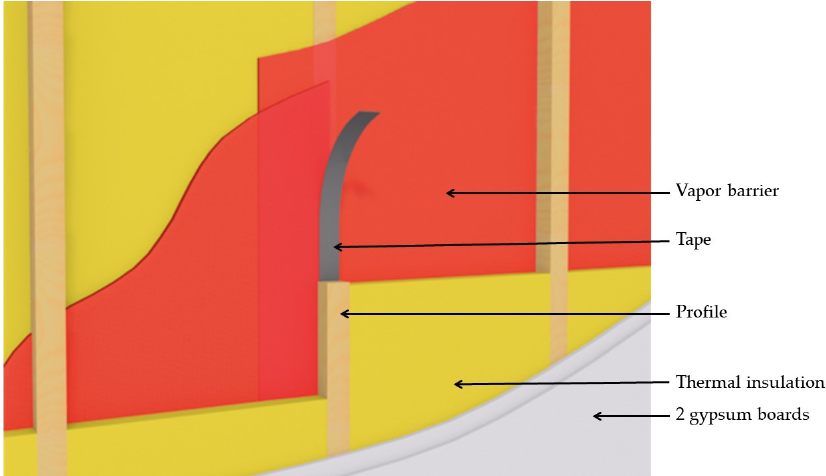
Figure 1. Exterior timber stud wall, where the vapor barrier system (shown in red) with a joint between two lengths of membrane sealant with tape (shown in grey), is mounted on the warm side of the thermally insulated exterior building envelope.